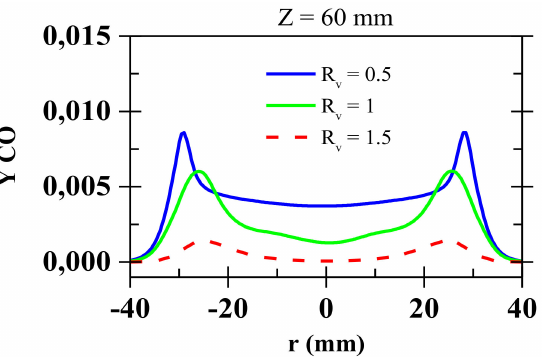
Figure 14. Radial profiles of CO mass fractions for different velocity ratios at Z = 60 mm.